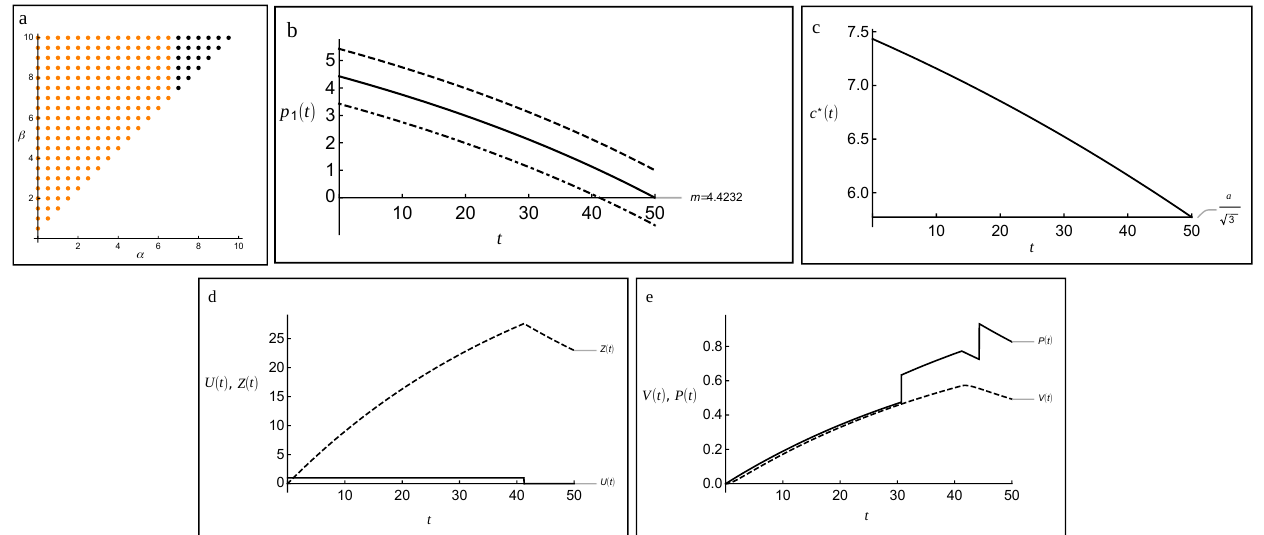
Figure 7. ( a ) Initial state; ( b ) dependence p 1 ( t ) , graphs of the functions p 1 ( t ) ± 1.0 are given for clarity; ( c ) the price function depending on the time; ( d ) functions U , Z depending on the time; ( e ) functions V , P depending on the time. Values of the parameters of the dynamic system: a = 10, U 0 = 1, T = 50, k 1 = 1.0.